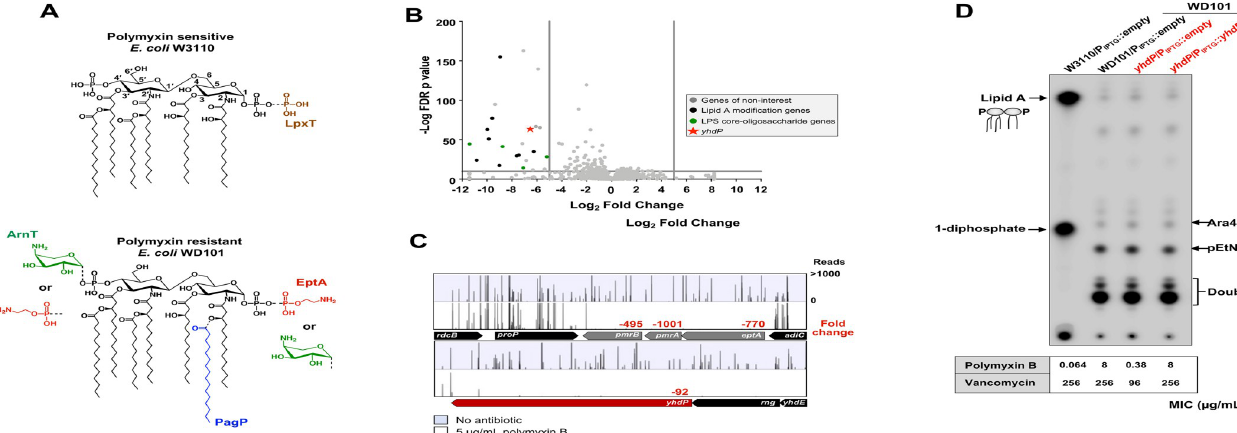
Fig 1. Tn-Seq analysis of polymyxin resistant E . coli identifies yhdP to be essential in the presence of polymyxin. (A) In the presence of polymyxin, the PmrA transcriptional regulator increases expression of proteins required for modification of lipid A, such as EptA and ArnT. PmrA is a constitutively active in strain WD101. Top: Chemical structure of wild-type lipid A with additional phosphate added by LpxT in brown. Bottom: Structure of lipid A under conditions in which PmrAB are activated showing pEtN addition by EptA (red) and Ara4N addition by ArnT (green). PmrA activation leads to inhibition of LpxT. Also, an additional acyl chain (C16:0) can also be added by PagP (blue); however, PagP expression is not controlled by PmrAB. (B) Volcano plot of genes revealed by Tn-Seq analysis. Genes expected to be essential in polymyxin resistance have a cut-off of log 2 fold change < -4 (vertical grey line), and a False Discovery Rate (FDR) p value < 0.05 (horizontal grey line). (C) Tn insertion profile of yhdP . The sites of Tn insertions were identified by deep sequencing and mapped onto the W3110 reference genome. Shown are Tn insertion profiles of the pmrA and yhdP loci. The height of each line in the profile represents the number of sequencing reads corresponding to a Tn insertion at the indicated genome position. In red is the fold change of RPKM value of the genes listed in the presence of polymyxin relative to the absence of polymyxin control. A total of three biological replicates where completed. The profile shown is that of a single biological replicate, but the fold change is the average of all replicates. (D) 32 P-labeled lipid A profiles of yhdP mutants. Cultures were grown to mid-log phase at 37˚C and 100 μ M IPTG was used for plasmid induction. Lipid A was isolated, separated by TLC and visualized by phosphorimaging. Lipid A species are indicated. Polymyxin and vancomycin MIC from E-test are indicated below the TLC. Both TLC and antibiotic sensitivity data are representative of 3 biological